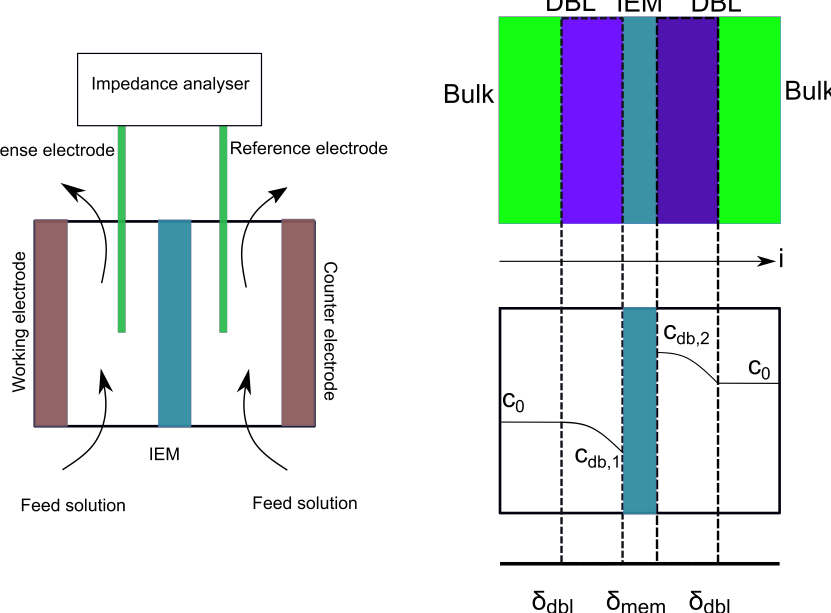
Figure 2. A flow cell configuration measuring membrane resistance using electrochemical impedance spectroscopy ( left ). Diffusion boundary layer (DBL) near the surface of a cation-exchange membrane and the salt concentration distribution in different layers at steady state ( right ). The current direction is to the